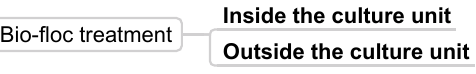
Figure 10. Partial taxonomy: Earthen-pond/reservoirs.